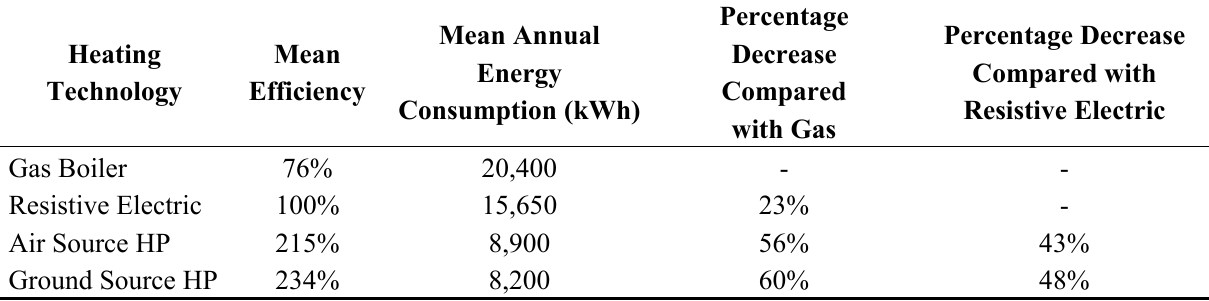
Table 4. Annual energy consumption per property fitted with different heating